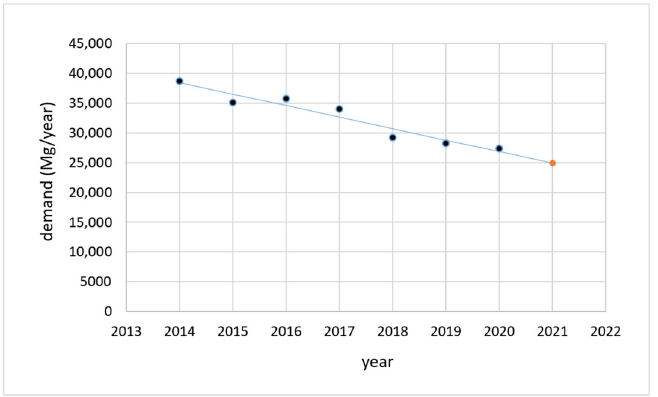
Figure 4. Demand of the “Export 1” group in the years 2014–2020 with the forecast for 2021.